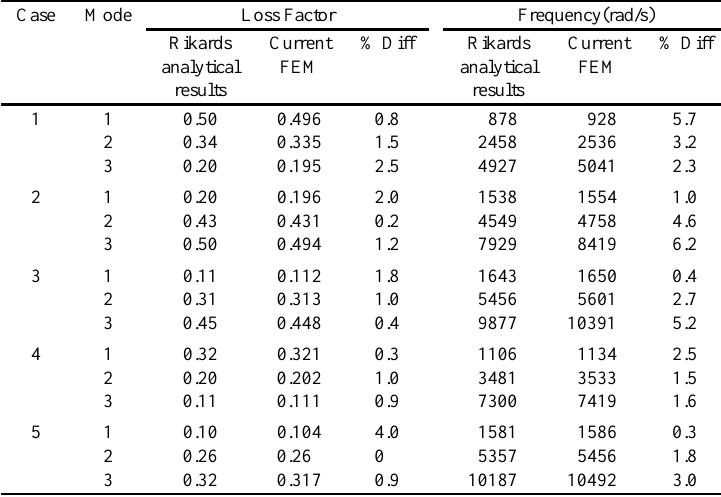
Table 2 Comparison of Rikards solution [5] to FEM results from this work